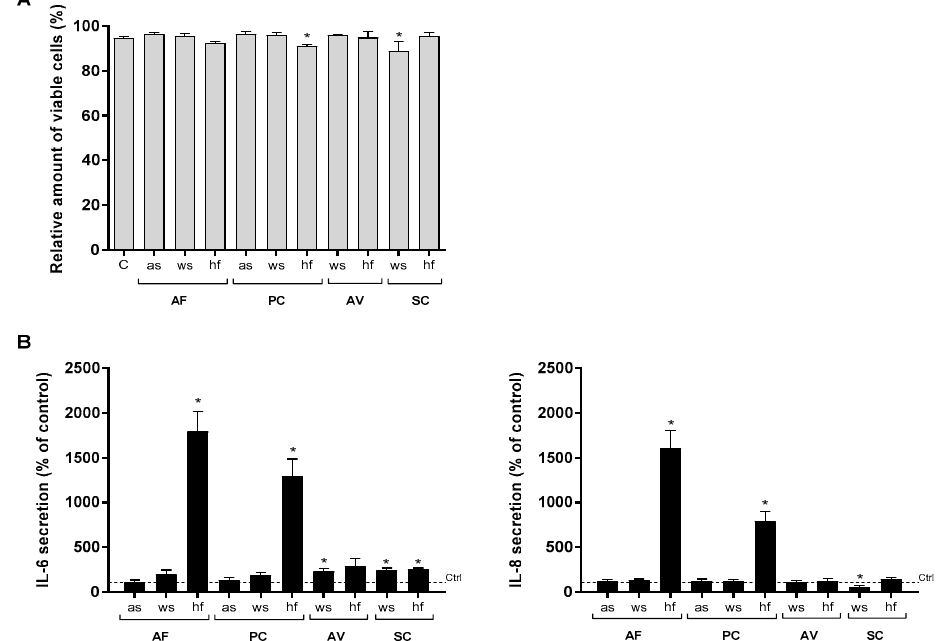
Figure 1. Cell viability and cytokine/chemokine release after exposure to spores and hyphal fragments from various mold species. BEAS-2B cells were exposed to 100 µ g dry weight/mL of X-ray treated aerosolized spores (as), washed spores (ws) or hyphal fragments (hf) from A. fumigatus (AF), P. chrysogenum (PC), A. versicolor (AV), S. chararum (SC) or medium (control) for 6 h, and assessed for: ( A ) cytotoxicity by staining with PI and Hoechst and analyzed with fluorescence microscopy. The results represent mean ± SEM of >3 independent experiments. Statistical analyses were performed by one-way ANOVA with Dunnett’s post-tests on log transformed datA. Significant difference compared to the control denoted by * p < 0.05, or ( B ) IL-6 and IL-8 release measured by ELISA. Bars represent mean ± SEM concentrations of >6 independent experiments. Statistical analyses were performed by two-way ANOVA with Dunnett’s post-tests on 2-step normalized data. Significant difference compared to the control denoted by * p < 0.05.